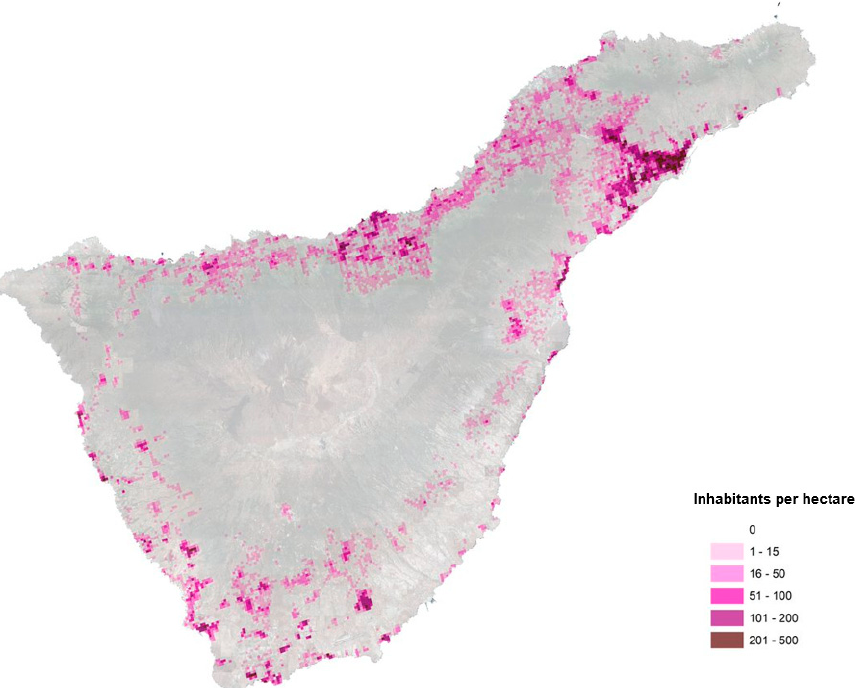
Figure 1. Distribution of the population on the island of Tenerife.